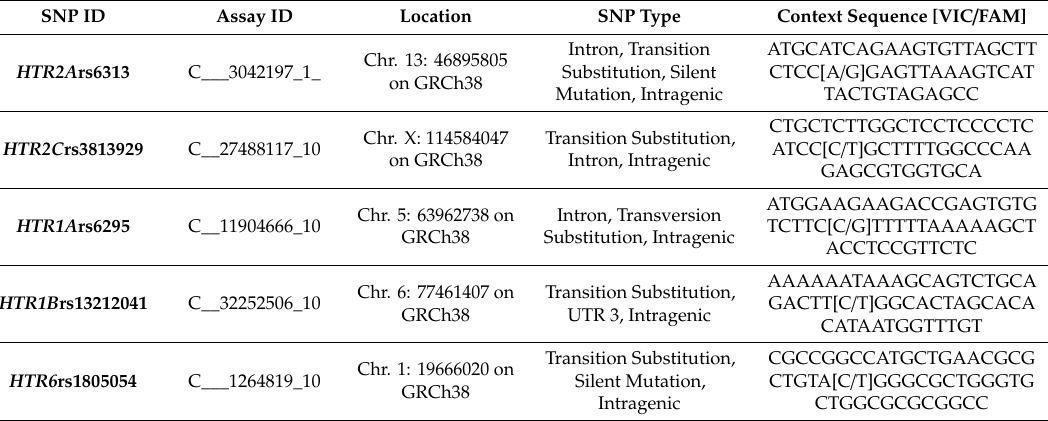
Table 6. Details of the 5-HT receptor gene polymorphisms analyzed in the